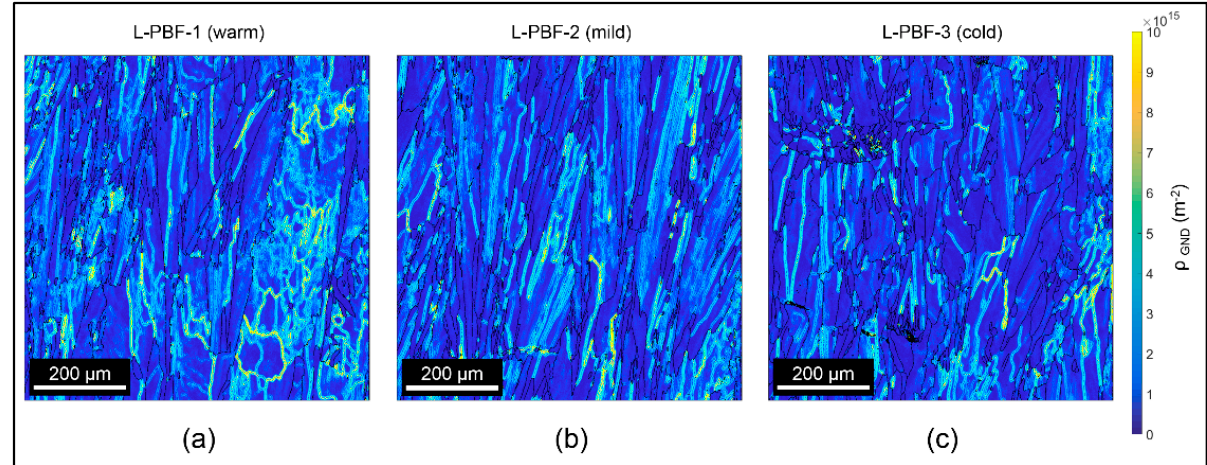
Figure 10. GND maps of as-built ( a ) warm, ( b ) mild, and ( c ) cold L-PBF microstructures. The corresponding average dislocation densities were 2.34 × 10 15 m − 2 ( a ), 1.97 × 10 15 m − 2 ( b ), and 1.62 × 10 15 m − 2 ( c